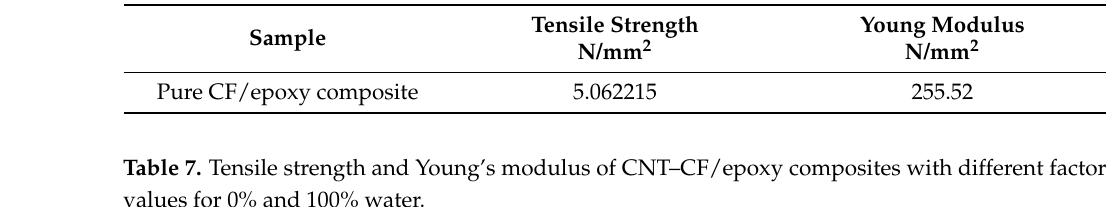
Table 6. Tensile strength and Young’s modulus of pure CF/epoxy composite.